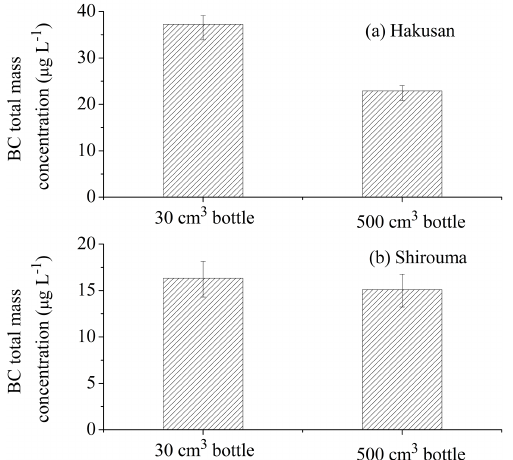
Figure 5. Total mass concentration of BC in (a) Hakusan and (b) Shirouma snow samples melted in 30cm 3 bottles and a 500cm 3 bottle.